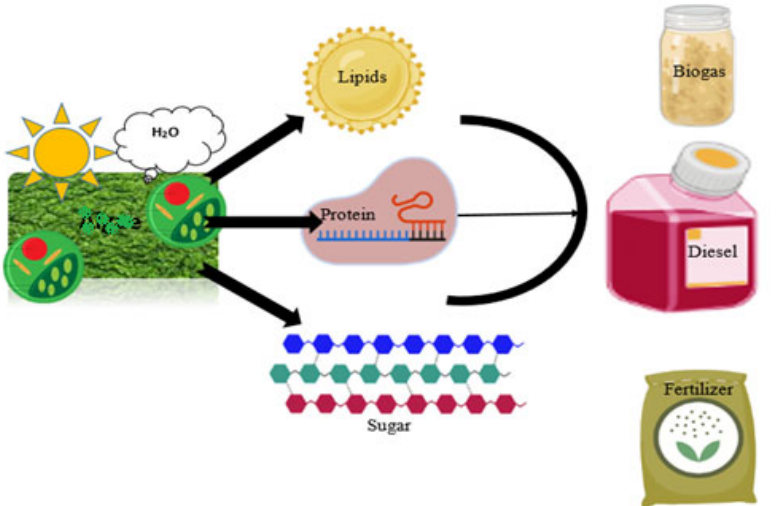
Figure 1. Fungal species utilize sunlight and water for the metabolic production of lipids, protein, and sugar used for the manufacturing of biodiesel, biogas, and biofertilizers.